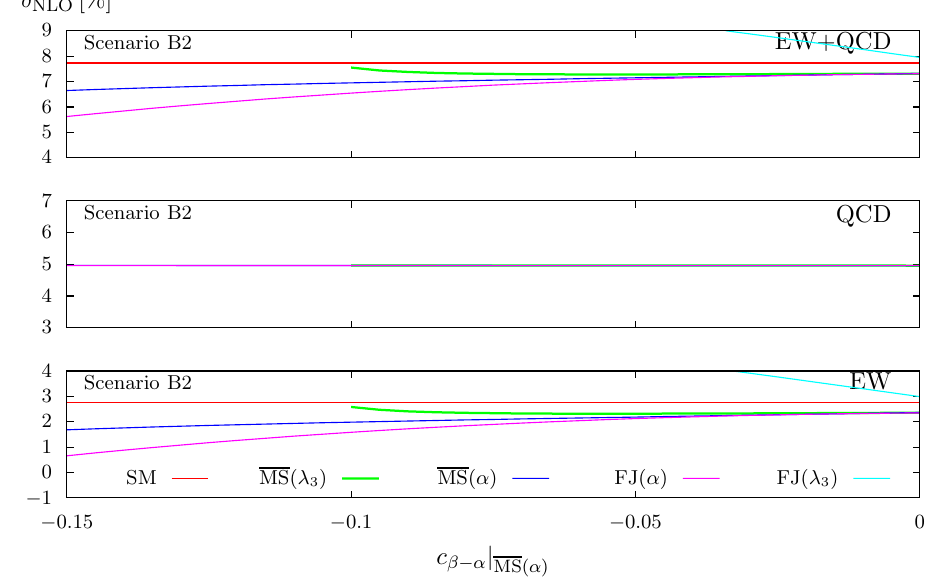
Figure 31 . The relative NLO EW+QCD, QCD, and EW corrections to the h scenario B2. The input is de(cid:12)ned in the MS( (cid:11) ) scheme and the corrections are computed in all four schemes which are displayed together with the SM corrections using the colour code of (cid:12)gure 12. Note that the results including only the QCD corrections lie on top of each